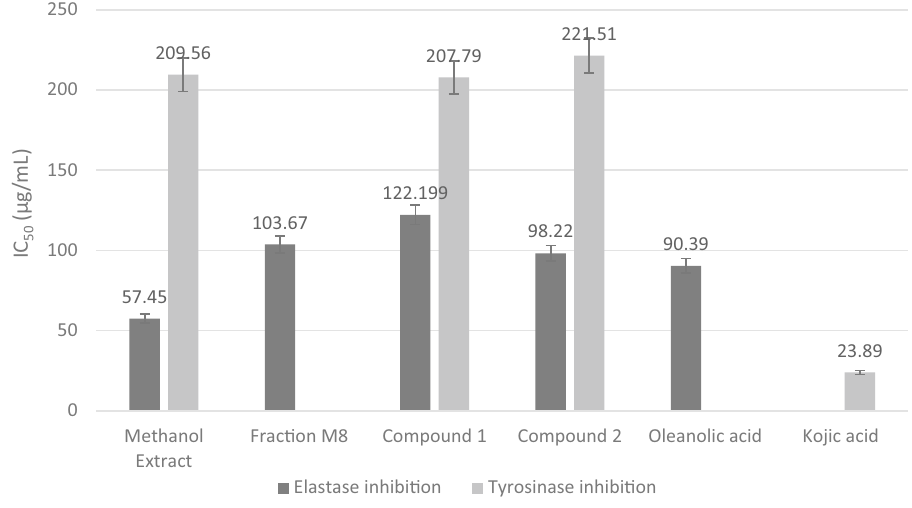
Figure 4. Anti elastase and anti-tyrosinase activities of extracts and isolates from R. fraxinifolius leaves.